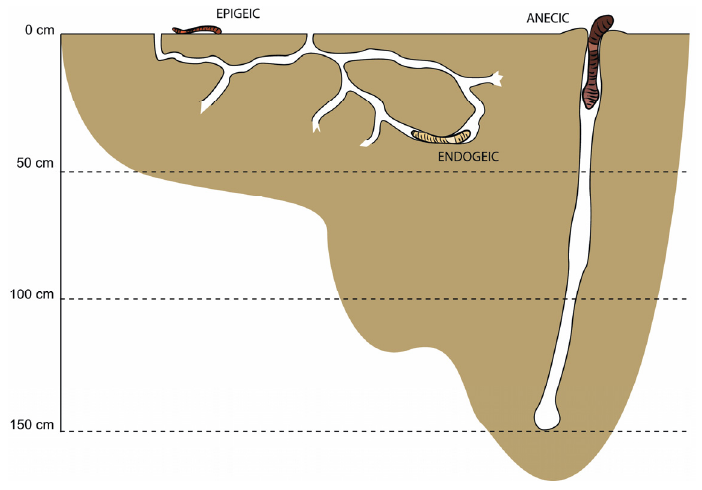
Figure 1. Illustration of the three ecological earthworm groups according to their food preference and behavior. The brown zone represents the soil. Reproduced from [22].